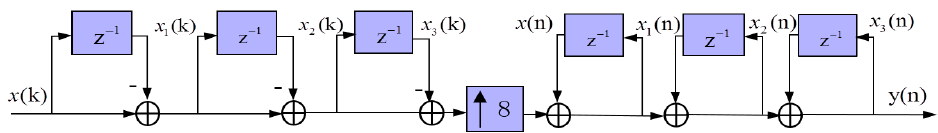
Figure 1. 8× interpolation CIC filter with three stage cascade structure. Figure 1. 8 × interpolation CIC filter with three stage cascade